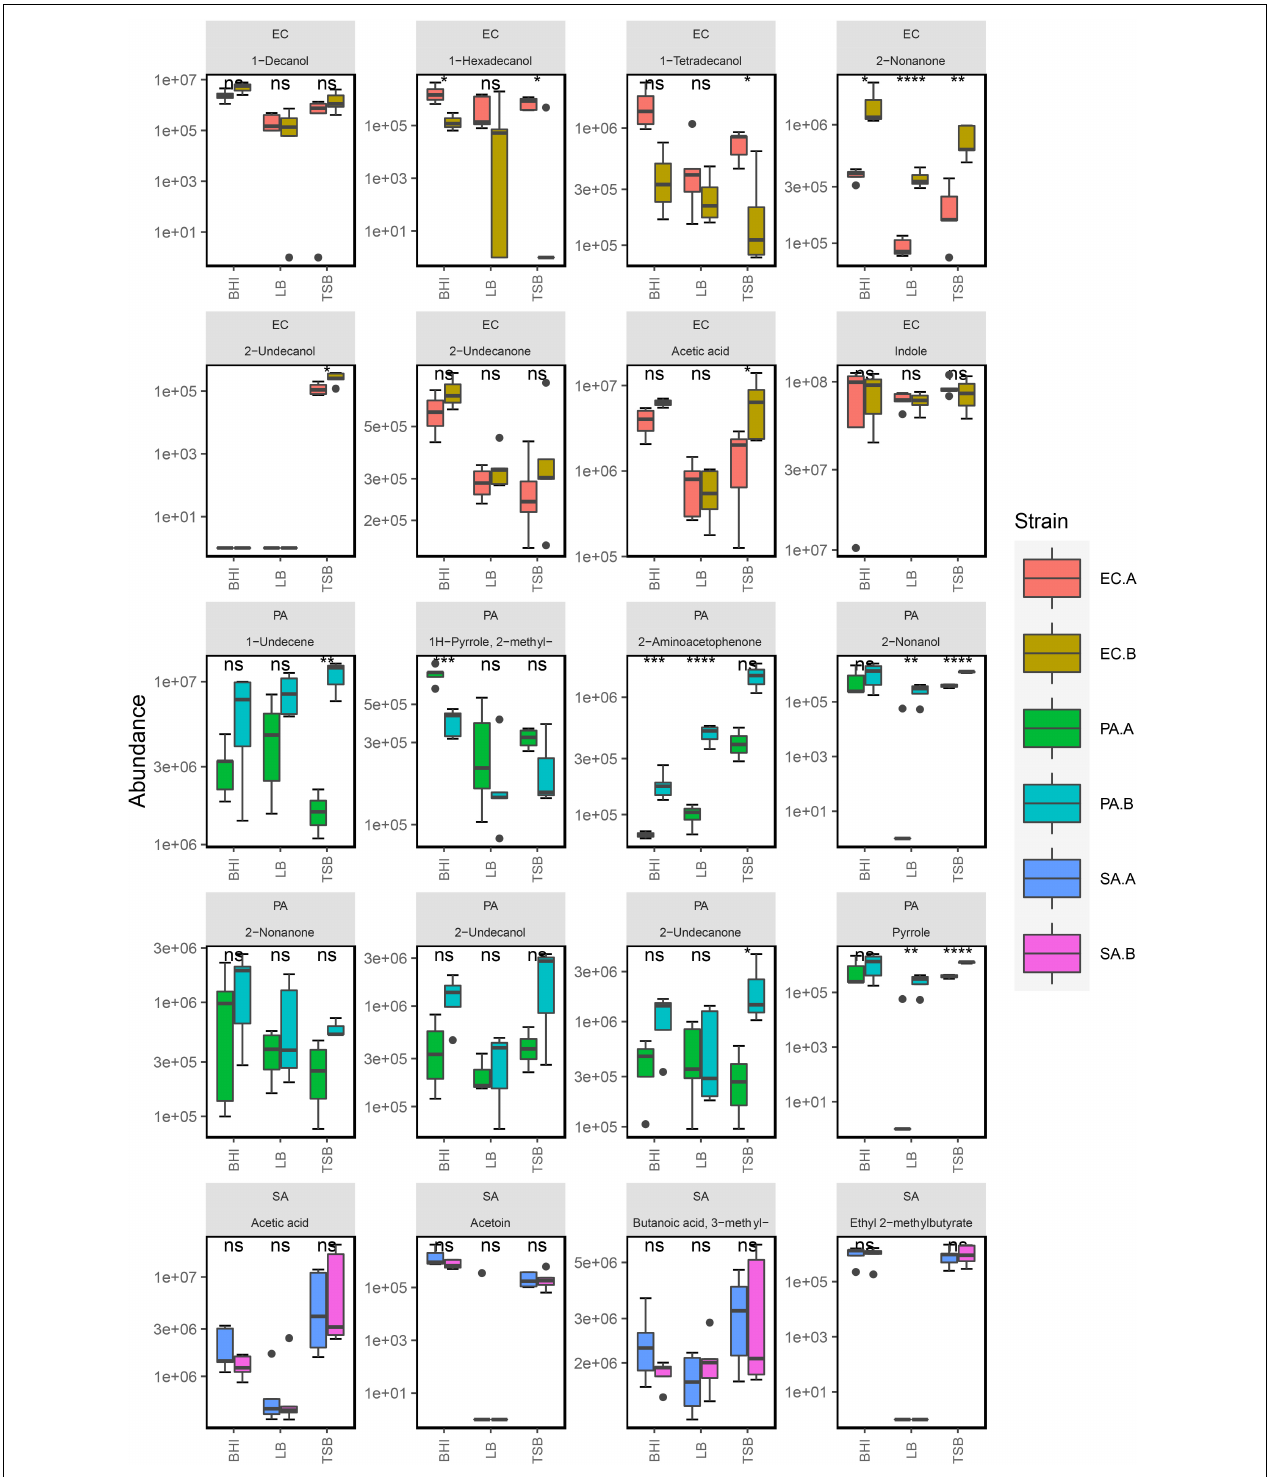
FIGURE 3 | Box plot representation of selected compounds emitted by S. aureus , P. aeruginosa , and E. coli strains in BHI ( n = 5), TSB ( n = 5), and LB media ( n = 5). *Five replicates were analyzed for each strain in each media except for E. coli (EC.A and EC.B) in BHI ( n = 4) and P. aeruginosa (PA.B) in TSB ( n = 3). The following symbols were used to indicate statistical significance of strain-level differences (ns: p > 0.05; * p ≤ 0.05; ** p ≤ 0.01; *** p ≤ 0.001; **** p ≤ 0.0001). The corresponding strain names to the abbreviated titles of the bacterial samples shown in this plot are as follows: EC.A: E. coli DSM103372, EC.B: E. coli DSM30083, PA.A: P. aeruginosa DSM105372, PA.B: P. aeruginosa DSM25642, SA.A: S. aureus DSM2569, SA.B: S. aureus DSM799.